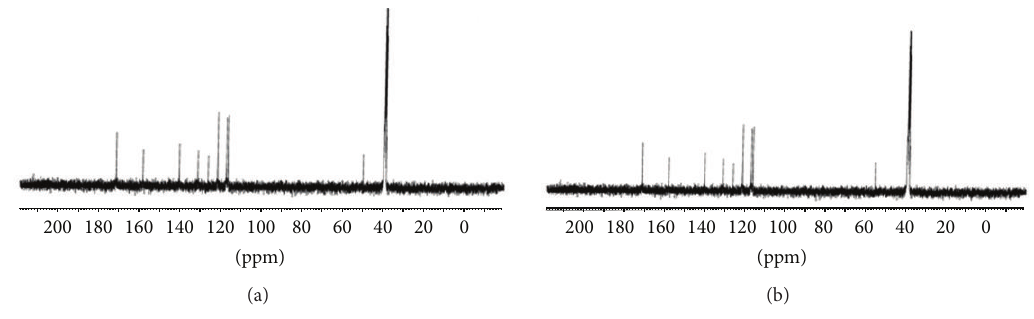
Figure 5: 13 C-NMR spectra of (a) BEF ligand and (b) BEF–Zn.